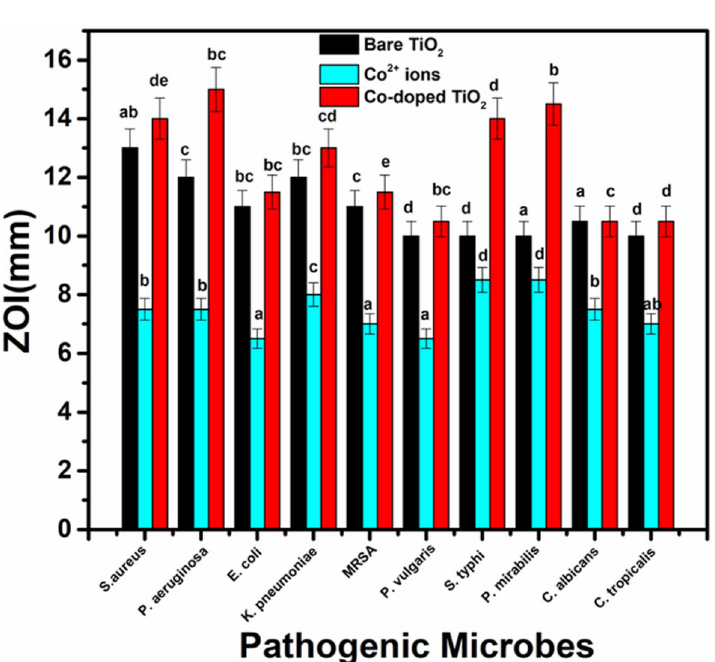
Figure 4. Antimicrobial activity of bare TiO 2 NPs and Co-doped TiO 2 NPs against different pathogenic microbes as ZIO. The data within the groups are analyzed using a one-way analysis of variance (ANOVA) followed by a,b,c,d,e Duncan’s multiple range